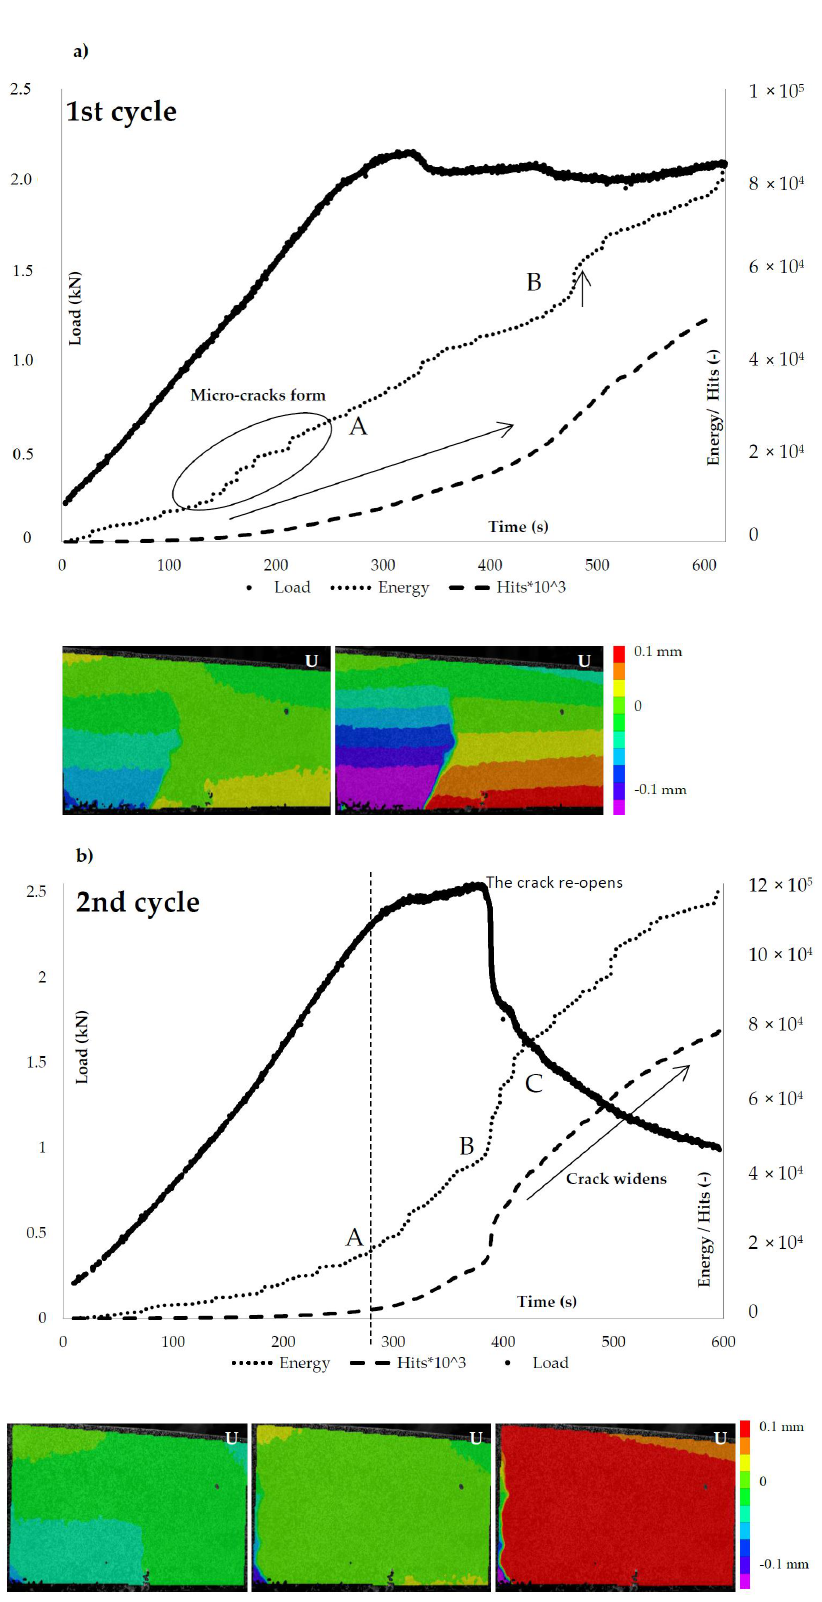
Figure 9. The cementitious (IPC) vascular system load response and AE hits activity: ( a ) loading (1st cycle); and ( b ) reloading (2nd cycle).